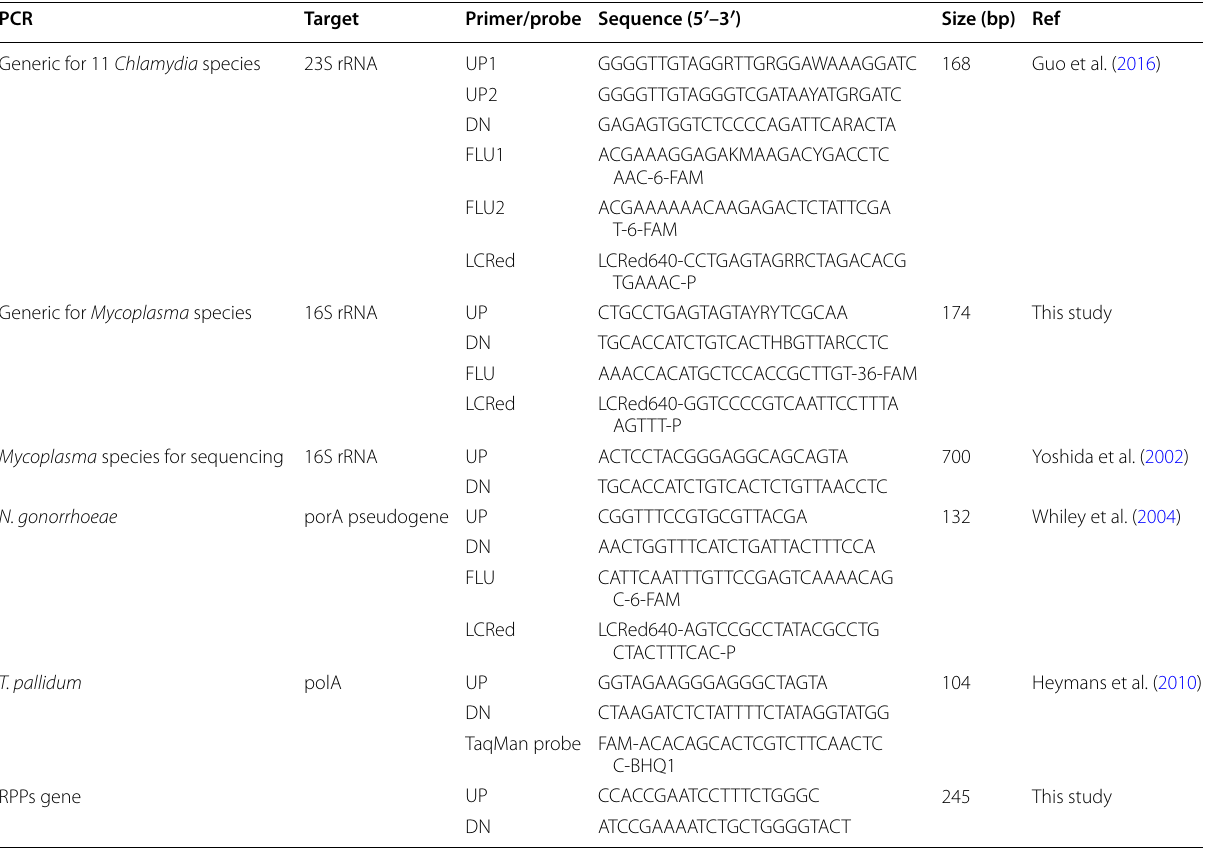
Table 1 Oligonucleotide primers used in this